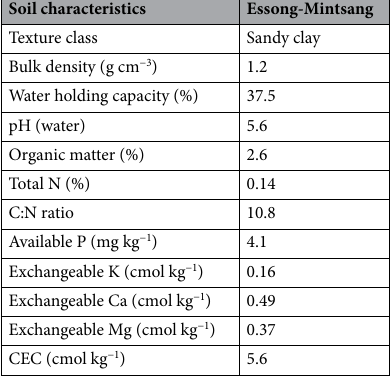
Table 2. Initial soil characteristics of the study